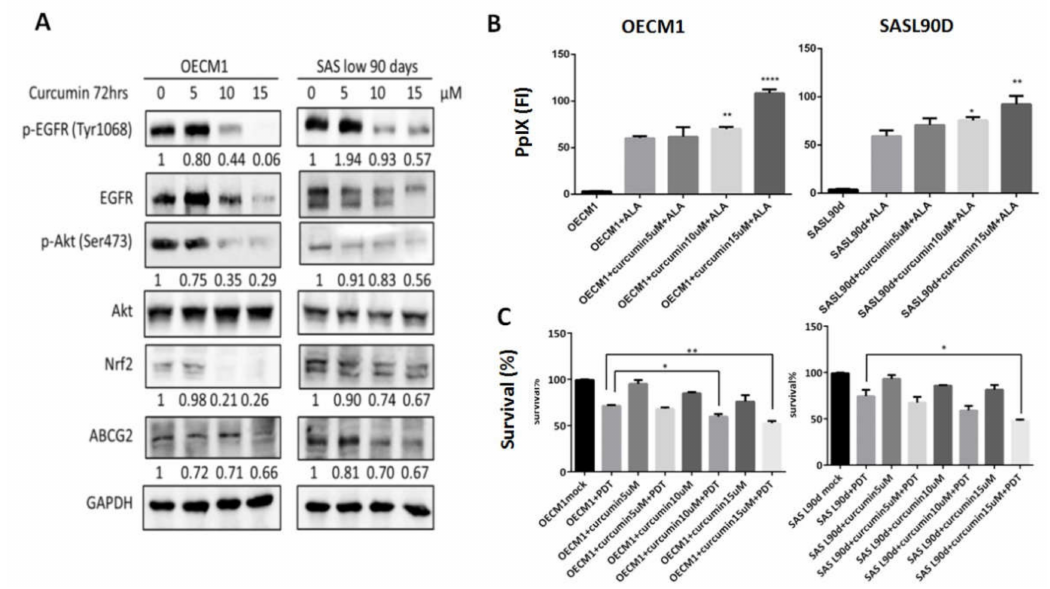
Figure 4. Curcumin treatment suppresses ABCG2 expression, increases PpIx accumulation, and decreases ALA-PDT-mediated HNC cell viability. ( A ) Western blot analysis for p-EGFR (Y1068), p-Akt (S473), Nrf2, and ABCG2 expression in OECM1 and SASL90d cells treated with di ff erent concentrations of curcumin. Curcumin inhibited EGFR and Akt signaling activities as well as ABCG2 and Nrf2 expression. In OECM1 and SASL90d, curcumin treatment ( B ) upregulated PpIX accumulation and ( C ) decreased cell viability in a dose-dependent manner. n ≥ 3; * p < 0.05; ** p < 0.01, **** p <